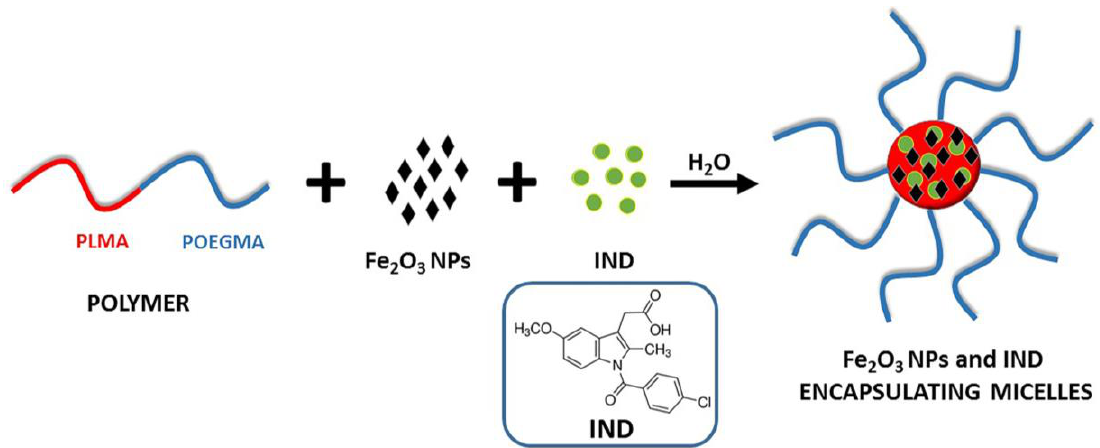
Scheme 2. Simplified schematic illustration for the preparation of the PLMA- b -POEGMA/NPs/IND mixed nanostructures.